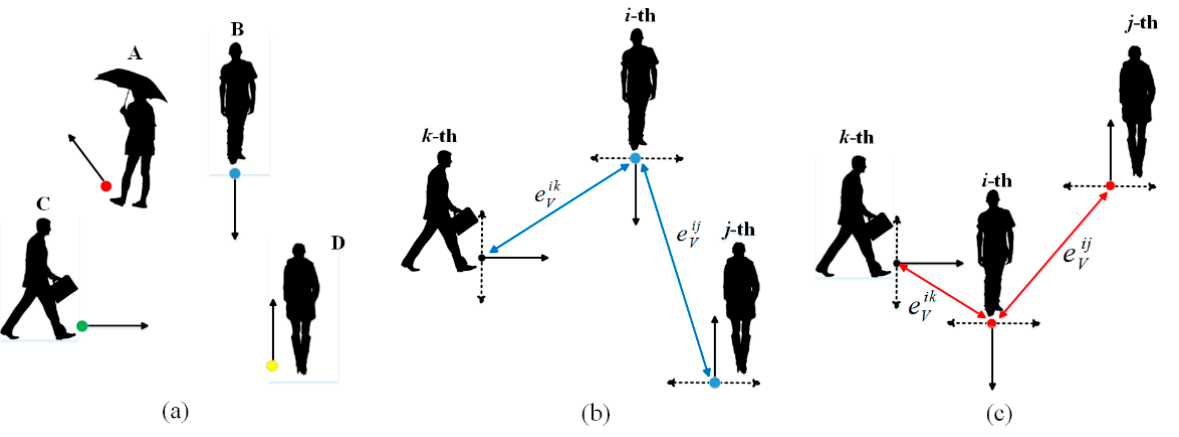
Figure 4. An illustration of the view diagram, “A–D” for four pedestrians, where the circle indicates the position of the pedestrian at the current moment, the dotted line indicates the boundary of the pedestrian’s view, the solid line indicates the movement direction of the pedestrians, and the blue and red lines indicate the influence vector between the i -th pedestrian, the j -th pedestrian, and the k -th pedestrian.